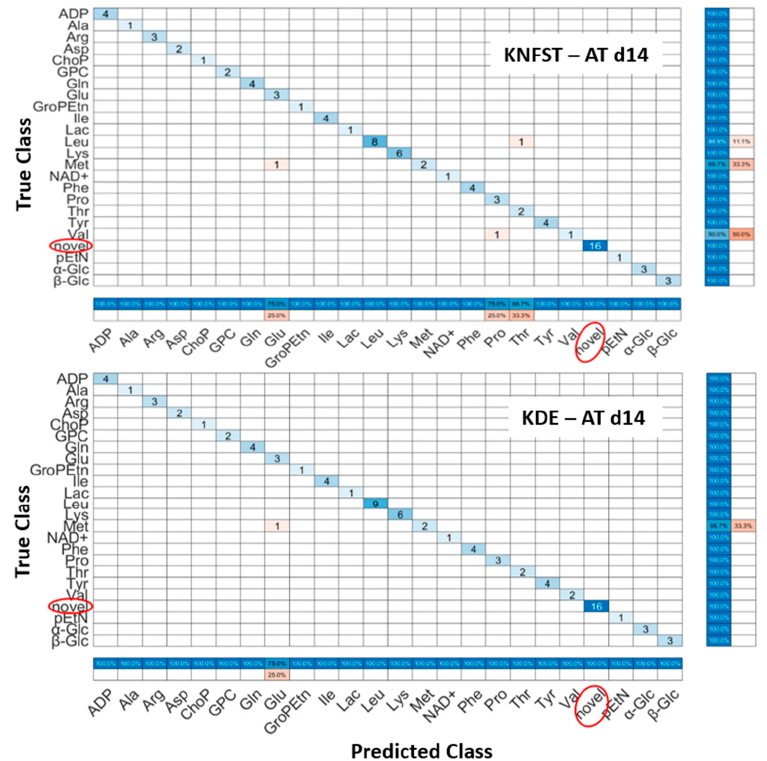
Figure 7. Confusion matrices of the output of classifiers KNFST and KDE for the spectra of 14 days of adipocyte differentiation. OS d14: Figure 8 shows the confusion matrices for the output of the classifier KNFST and KDE for the OS d14 sample. Both classifiers were able to detect all six